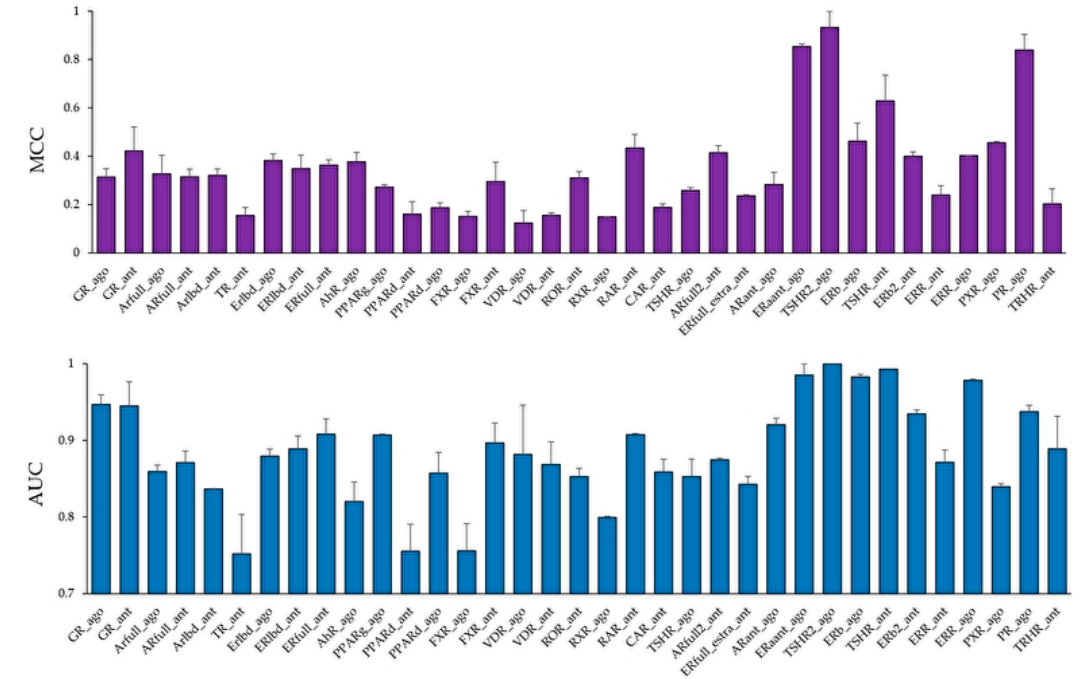
Figure 4. Average Matthews correlation coefficient (MCC) (top) and area under the curve (AUC) (bottom) values in the Test dataset in the models of 35 NR agonists and antagonists constructed by DeepSnap-DL. n = 2. Each bar indicates average MCC and AUC ± standard error.